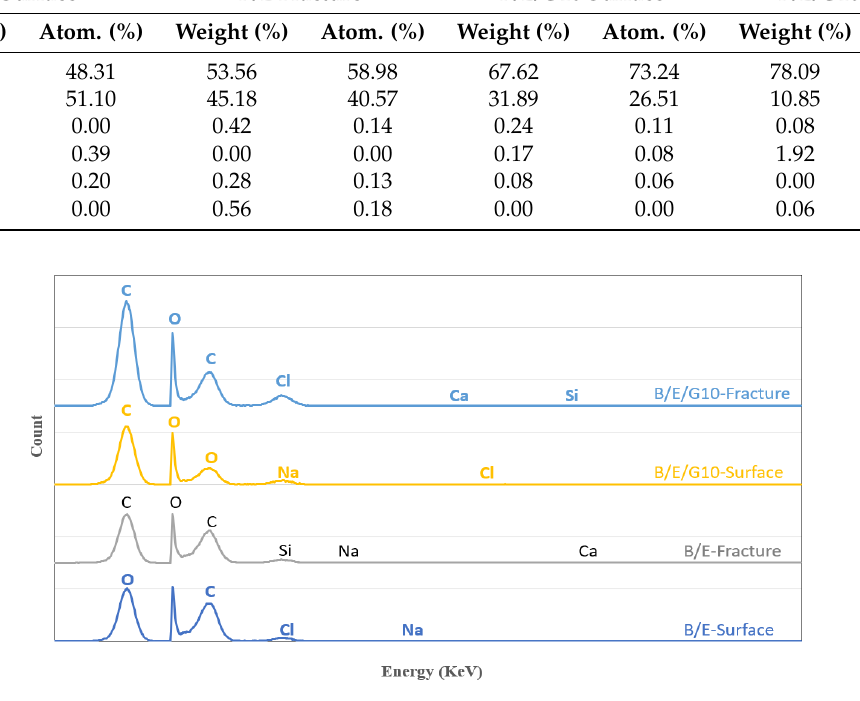
Figure 12. SEM-EDX spectrum analysis on hybrid composites at surface and fracture position.